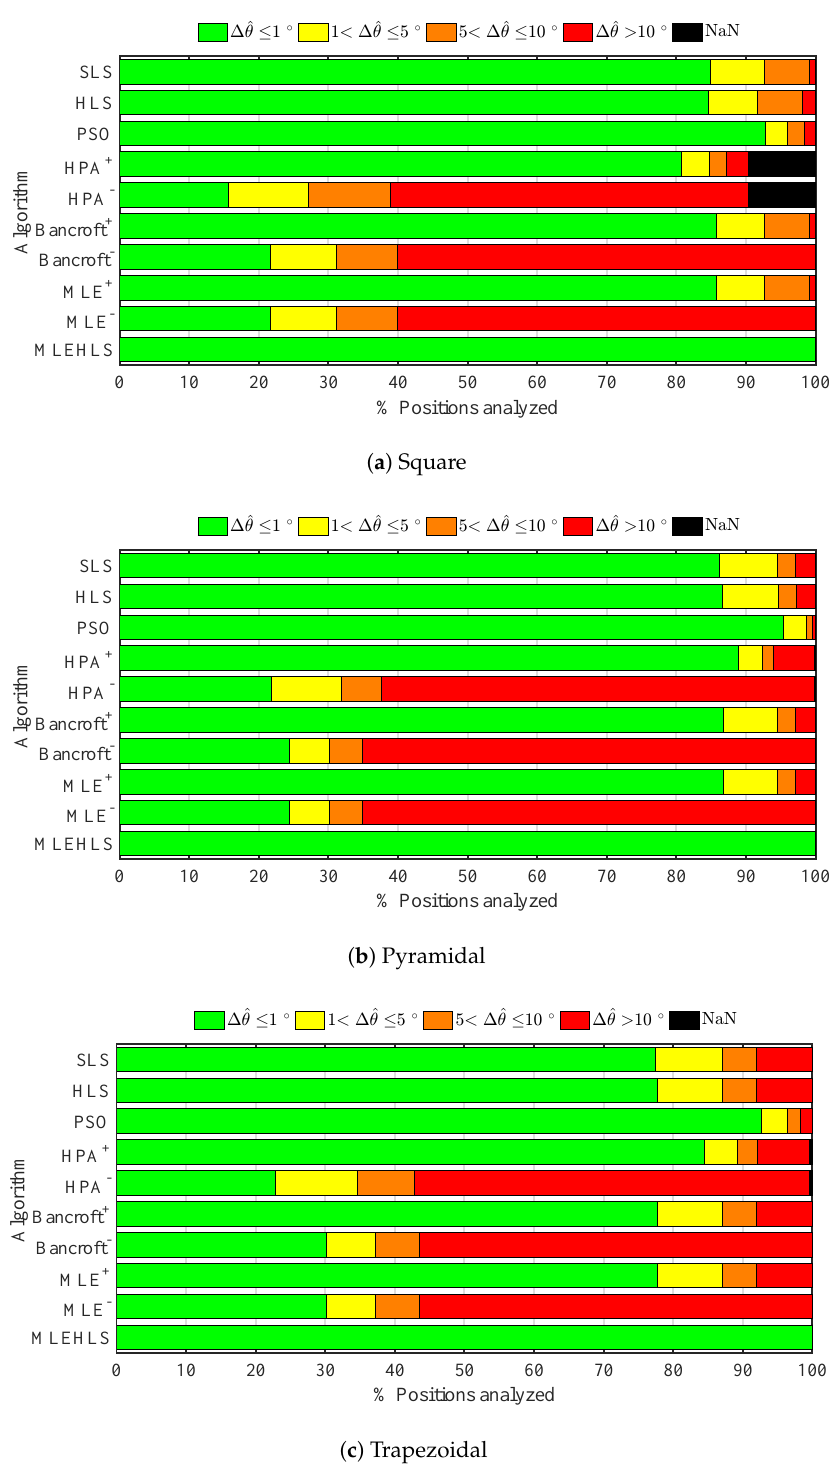
Figure 5. Percentage of positions located within the errors in the elevation angle ∆ ˆ θ in degrees defined in the legend under theoretical conditions for each algorithm and antenna array